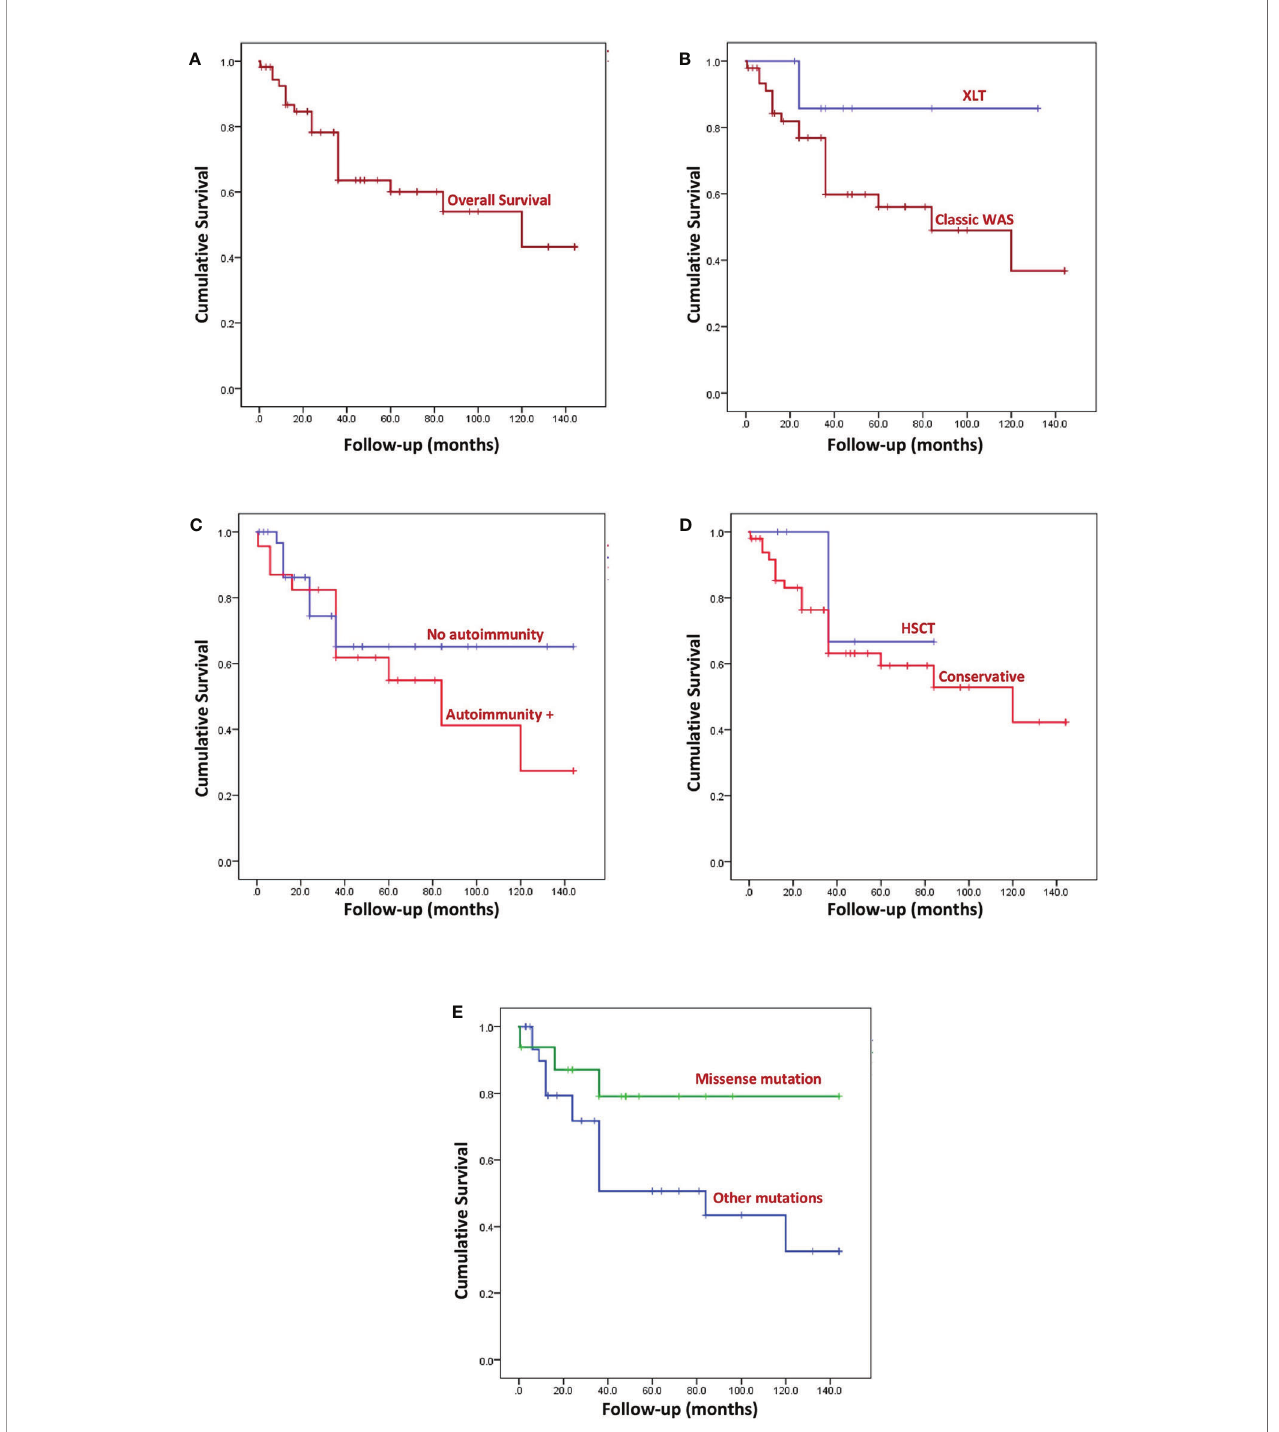
FIGURE 4 | Kaplan Meier survival curves. (A) Overall survival (OS) of the entire cohort. Median follow-up was 36 months (range: 2 weeks- 12 years). (B) Comparison of OS between XLT and WAS, (p 0.154). (C) Comparison of OS of patients with autoimmune manifestation and without autoimmunity, (p 0.410). (D) Comparison of OS of patients who underwent HSCT and patients who were not transplanted, (p 0.543). (E) Comparison of OS of patients who had missense variants and those with variants other than missense mutation, (p